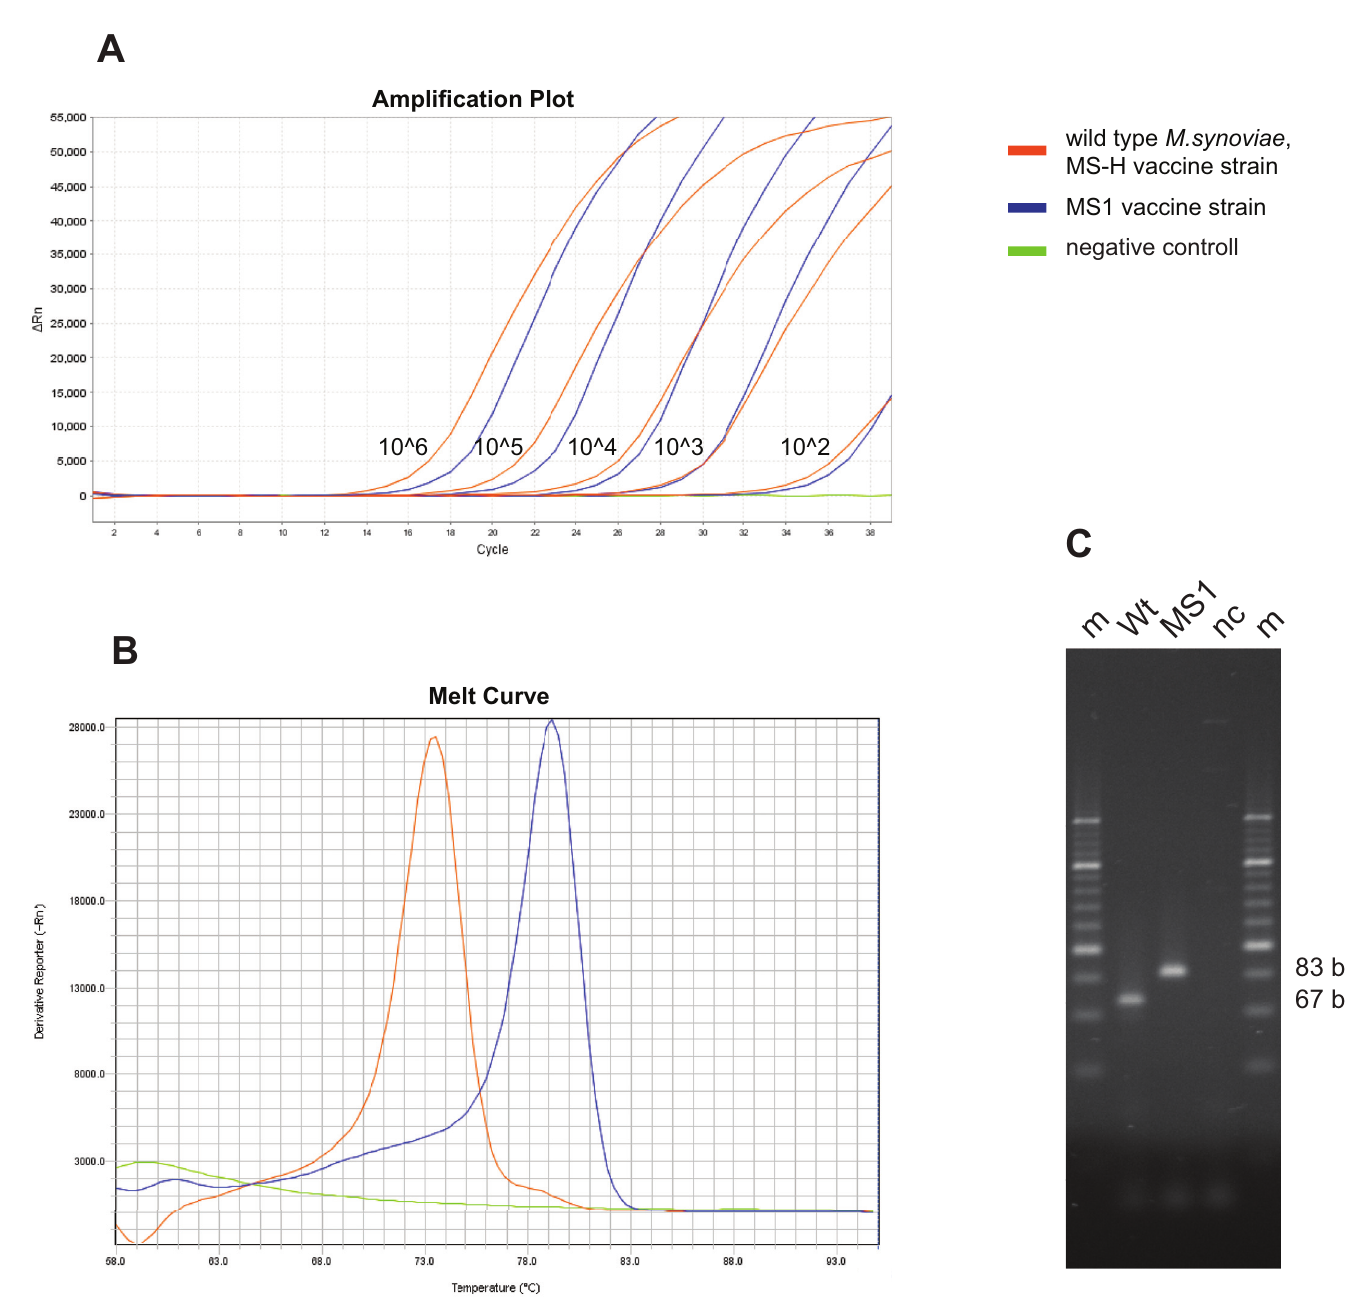
Fig 2. Amplification plot, melting-curves and PCR product sizes of MS1 melt- and agarose-MAMAs. Amplification plot ( A ) of dilution series of the MS1 vaccine strain (blue lines) and the M . synoviae type strain (WVU 1853, ATCC 25204, NCTC 10124; orangelines) showingthe sensitivity of the assay. Green line representsnegative control. Meltingcurves ( B ) show melting temperatures for the MS1 vaccine strain (T m : 79.3˚C; blue line) and wild-typeor MS-H vaccine strain (T m : 73.6˚C; orangeline). Electrophoresis ( C ) was performed in 3% agarosegel (MetaPhor Agarose, Lonza Group Ltd., Basel, Switzerland) and a 20-bp DNA ladder(O’RangeRuler 20 bp, Thermo Fisher Scientific Inc.) was used as molecularweight marker (m). The MS1 vaccine strain (MS1) yielded83 bp fragment, whilethe wild-typeor MS-H vaccine strain (Wt) produced67 bp fragments.